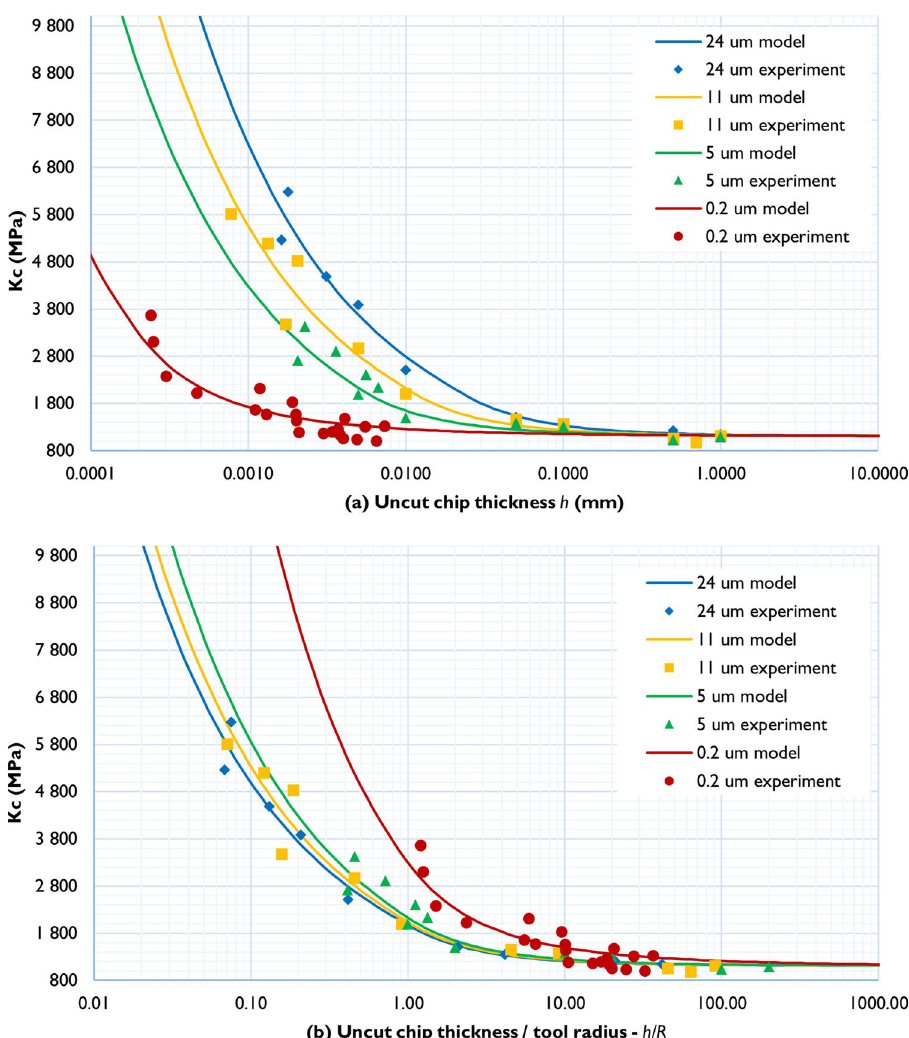
Figure 7. Analytical model (solid lines) and experimental data (points) for all tool edge radii: ( a ) specific cutting energy vs feed; ( b ) specific cutting energy vs RTS.